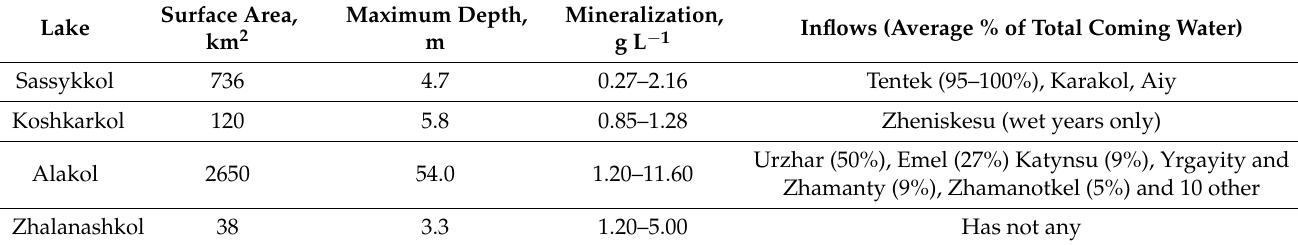
Table 1. General characteristics of Alakol lakes